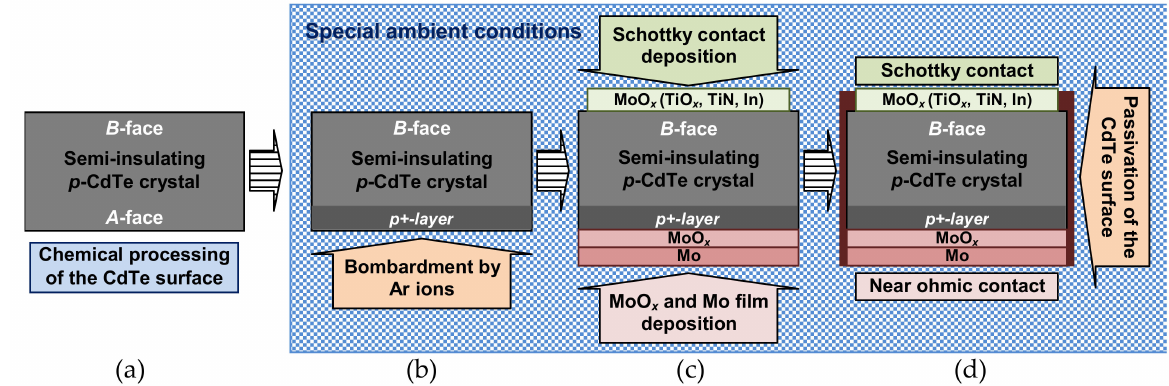
Figure 2. Schematic illustration of the fabrication procedures of MoO x (TiO x , TiN, In)/ p -CdTe/MoO x diode detectors: ( a ) chemical surface processing of the crystal; ( b ) bombardment by Ar ions to create a p + -layer on the CdTe(111) A surface; ( c ) Schottky (ohmic) contact formation; ( d ) passivation of the crystal